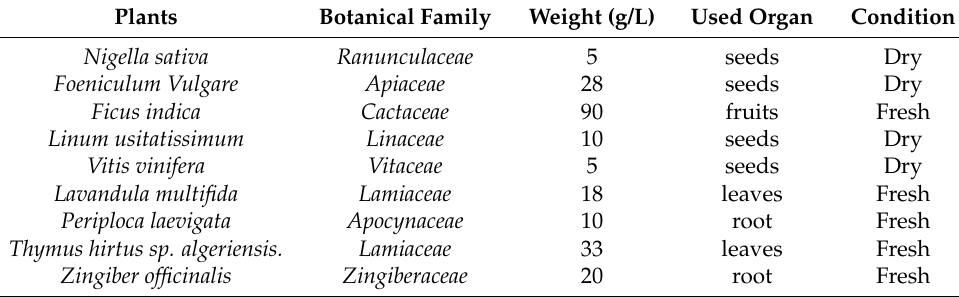
Table 1. Plant material used for the fermentation process. Plants Botanical Family Weight (g/L) Used Organ Condition Nigella sativa Ranunculaceae 5 seeds Dry Foeniculum Vulgare Apiaceae 28 seeds Dry Ficus indica Cactaceae 90 fruits Fresh Linum usitatissimum Linaceae 10 seeds Dry Vitis vinifera Vitaceae seeds Dry Lavandula multifida Lamiaceae leaves Fresh Periploca laevigata Apocynaceae root Fresh Lamiaceae 33 leaves Fresh Zingiber officinalis Zingiberaceae 20 root